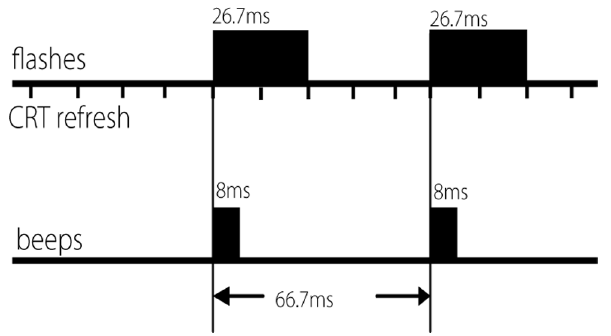
Figure 1. Flash beep stimulus timing. Shown is an example of a 2-flash, 2-beep (2F2B)